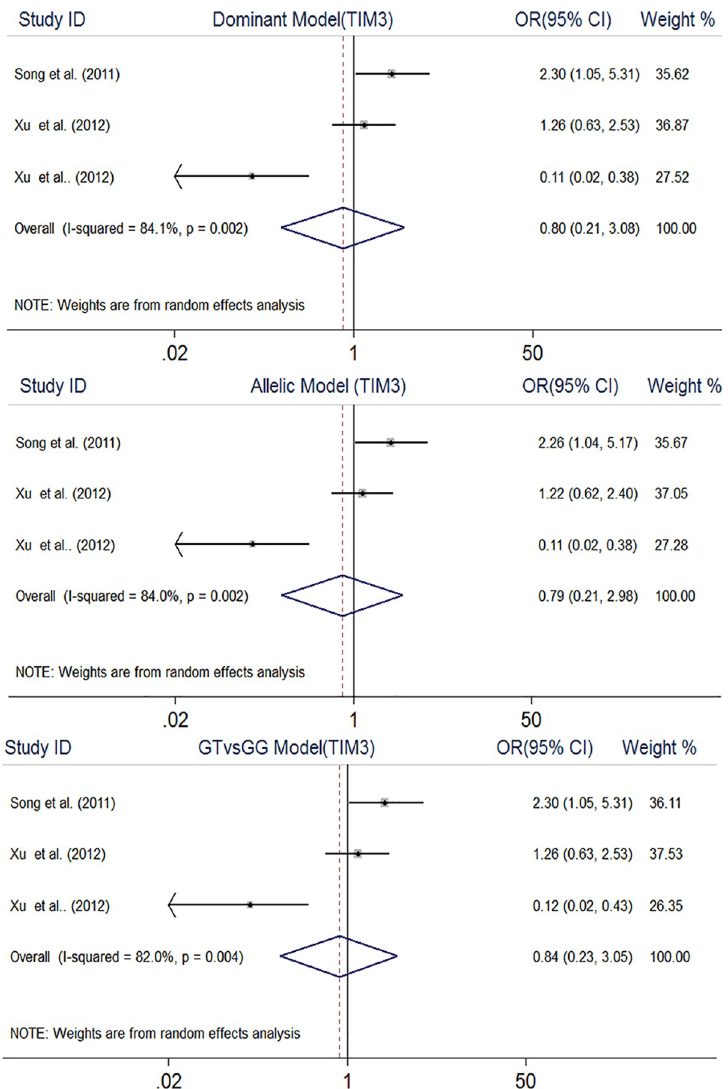
Fig 4. Forest plot of association between TIM3 rs10515746 gene polymorphism and rheumatoid arthritis.